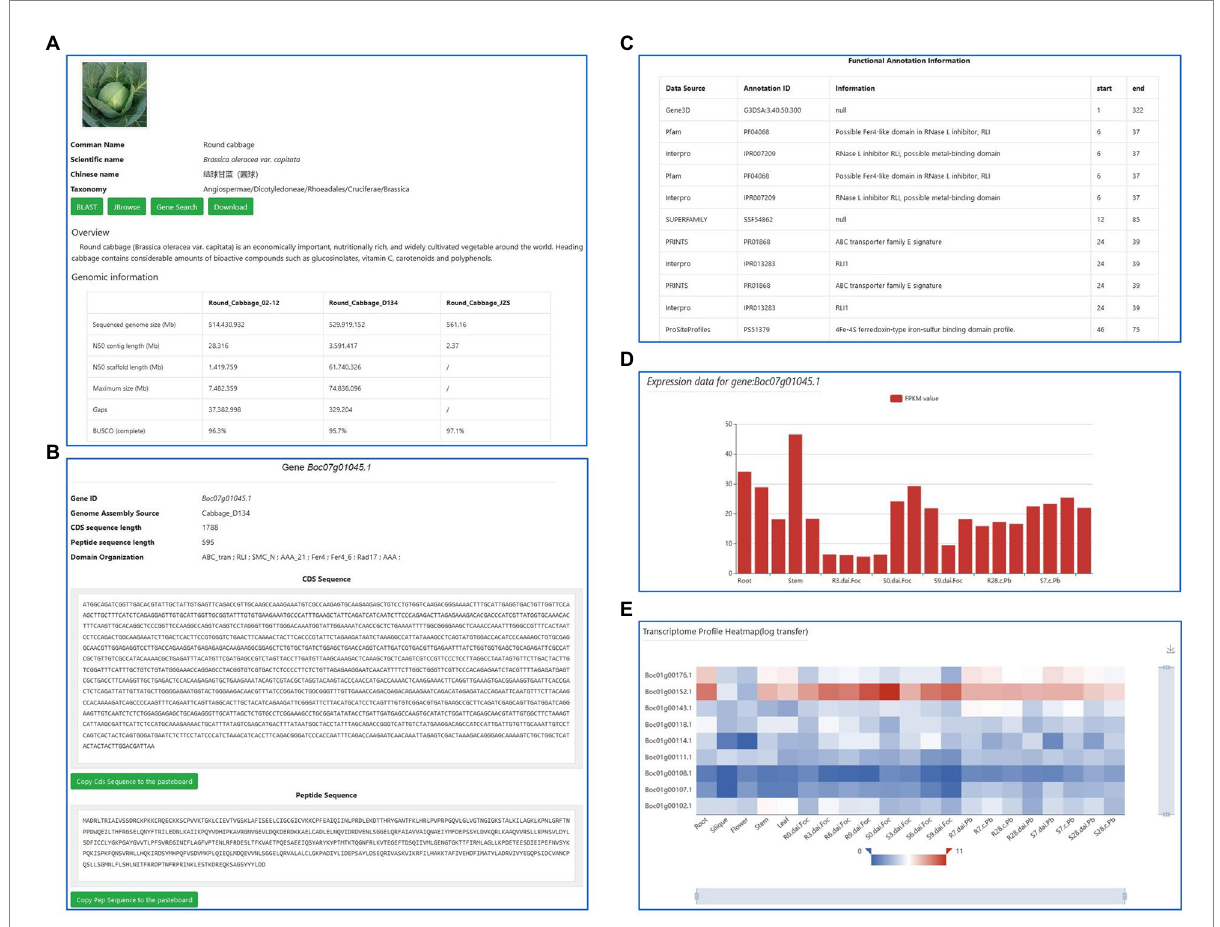
FIGURE 3 The “Gene search” and “Heatmap” modules. (A) The cultivar introduction and genome information. (B–D) The “Gene Search” module provides detailed gene information, including CDS, peptide sequence, annotation, and expression. (E) The dynamic, editable